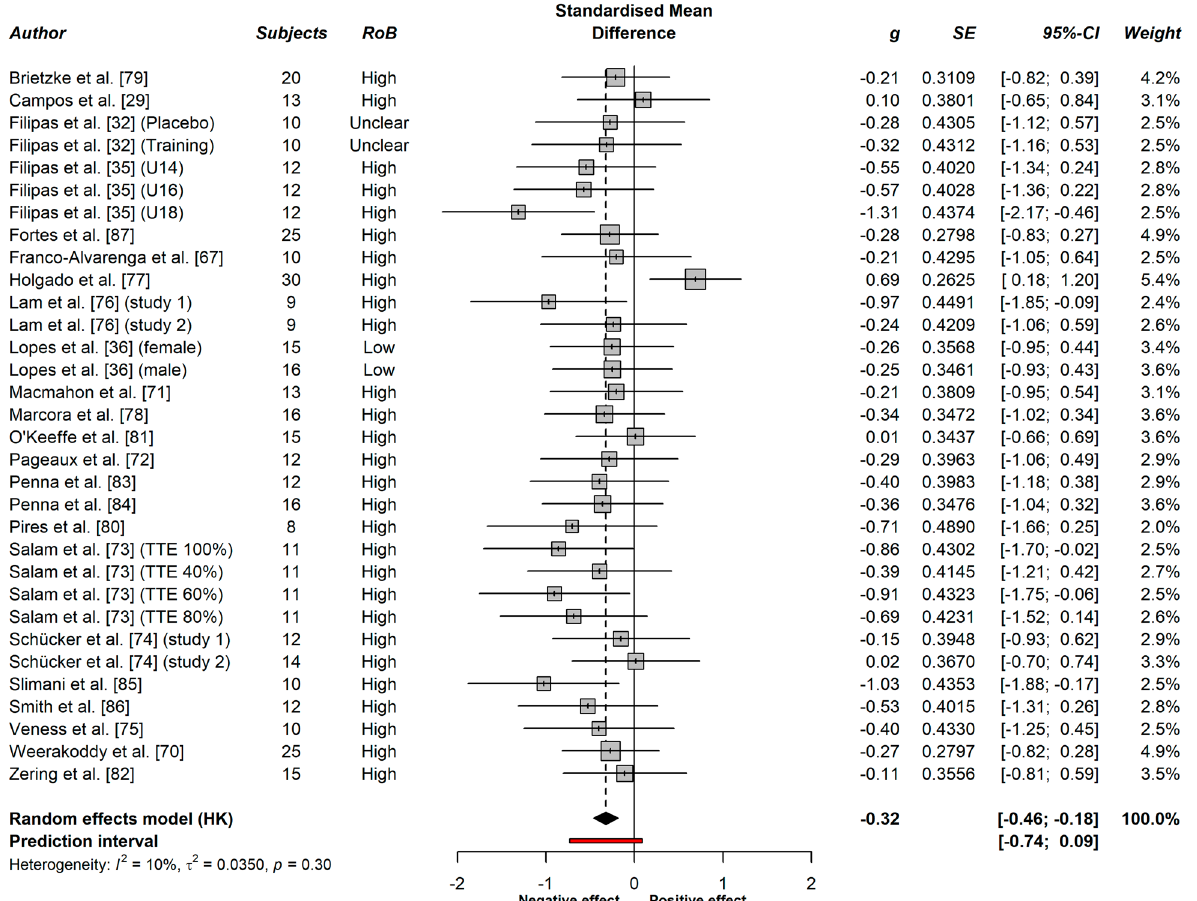
Fig. 5 Forest plot detailing the effect of mental fatigue on dynamic maximal whole-body endurance performance (random effects meta-analysis; 95%-CI 95% confidence interval; g =